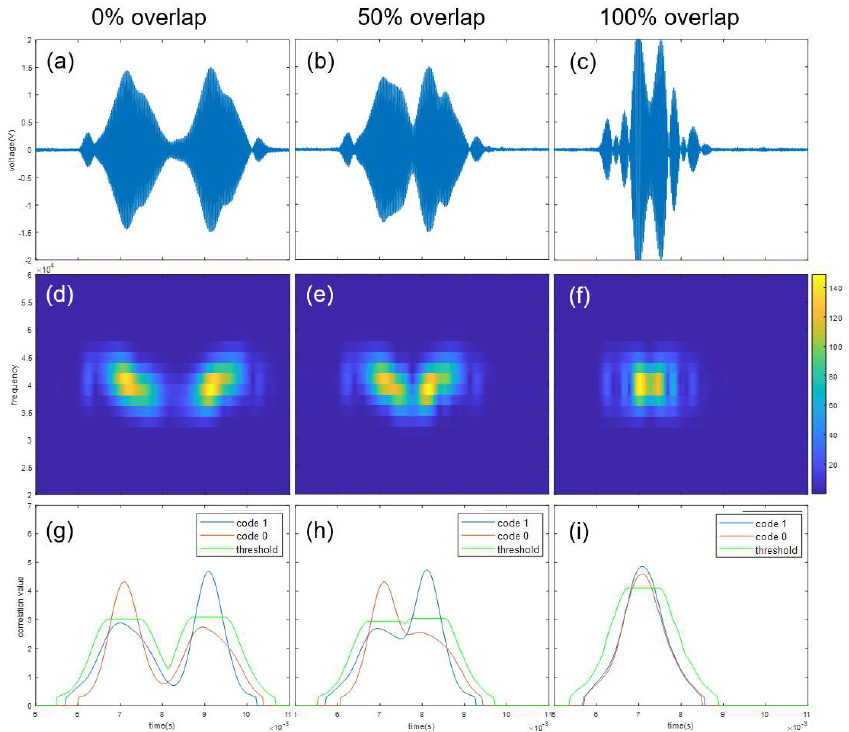
Figure 8. Demodulation results when two transmitters transmit the same bit codes, “1” and “0”. Shown are ( a , d , g )—0% overlap; ( b , e , h )—50% overlap; ( c , f , i )—100% overlap; ( a – c )—received signal; ( d – f )—spectrogram; and ( g – i )—code mask correlation result and threshold value.